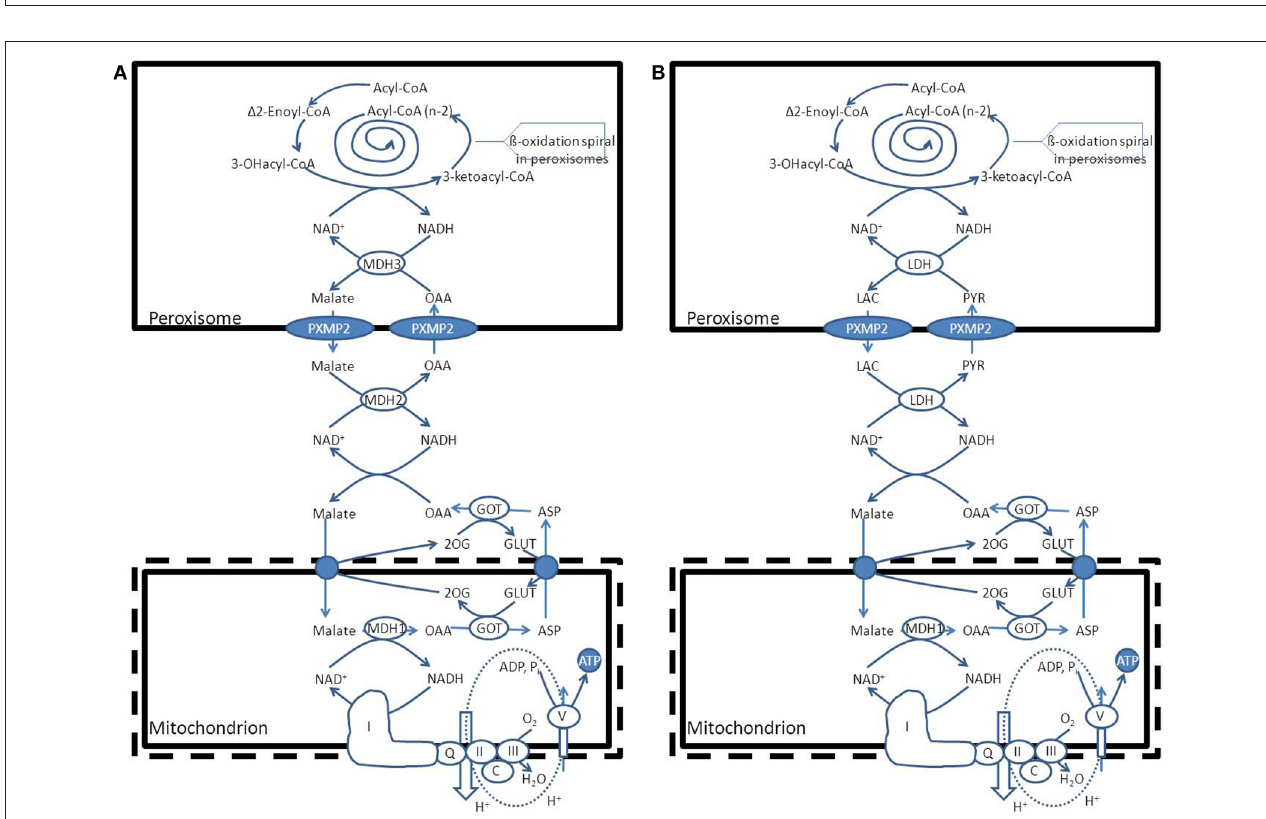
FIGURE 5 | Functional interplay between peroxisomes and mitochondria with respect to the reoxidation of NADH produced within the peroxisomal beta-oxidation system. (A) S. cerevisiae (see text for detailed information). (B) : H. sapiens . PYR, pyruvate; LAC, lactic acid; LDH, lactate dehydrogenase; GOT, glutamate oxaloacetate transaminase; ASP, L-aspartate, GLUT, L-glutamate; 2OG, 2-oxoglutarate; MDH1, mitochondrial malate